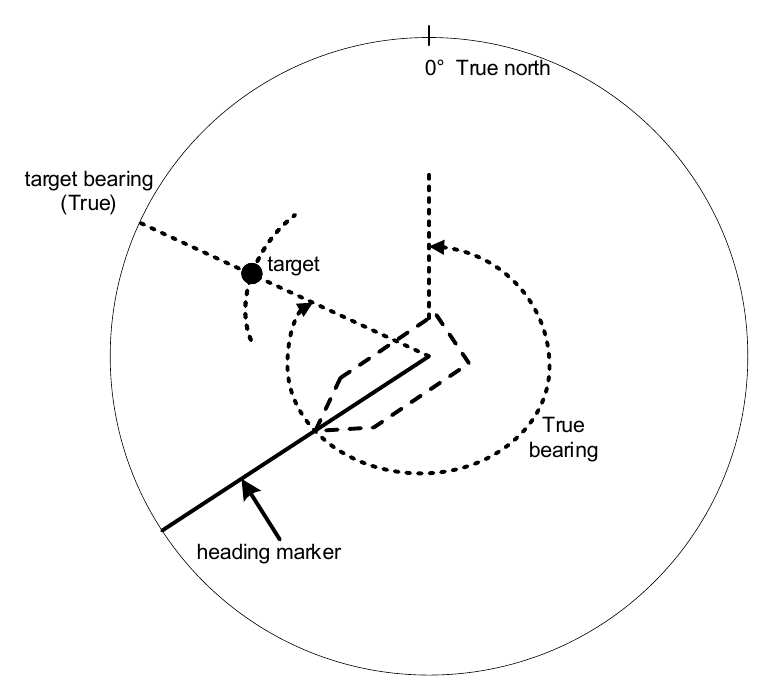
Figure 2. Measurement of true bearing.